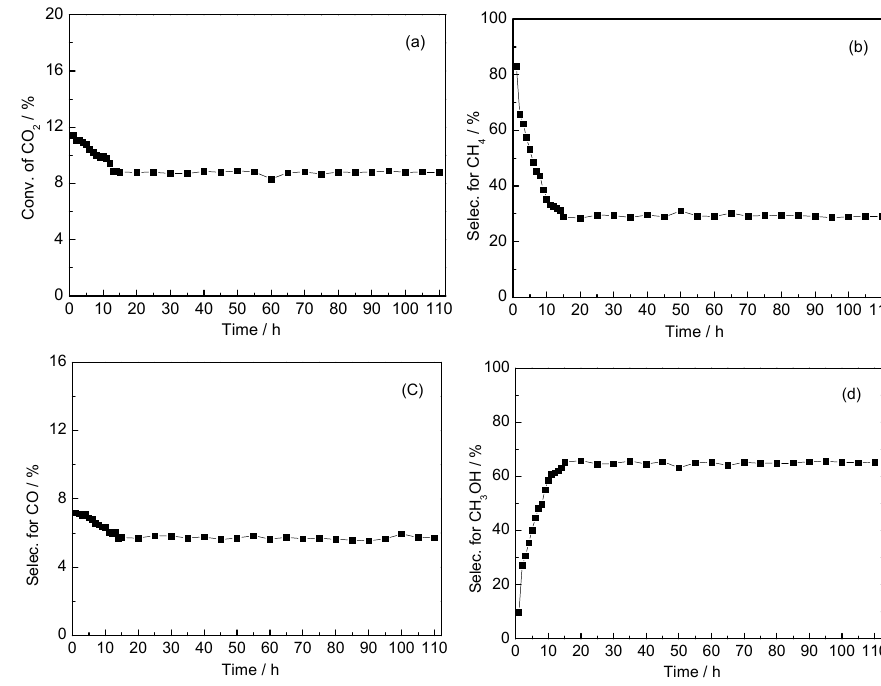
Figure 8. Catalytic performance of 20Cu20Mo 2 C/M41 ‐ I in CO 2 hydrogenation. ( a ) CO 2 conversion; ( b ) CH 4 selectivity; ( c ) CO selectivity; ( d ) CH 3 OH selectivity. Reaction conditions: catalyst 0.5 g, temperature 493 K, pressure 3.0 MPa (H 2 :CO 2 = 3:1), GHSV 3600 mL/(h ∙ g).